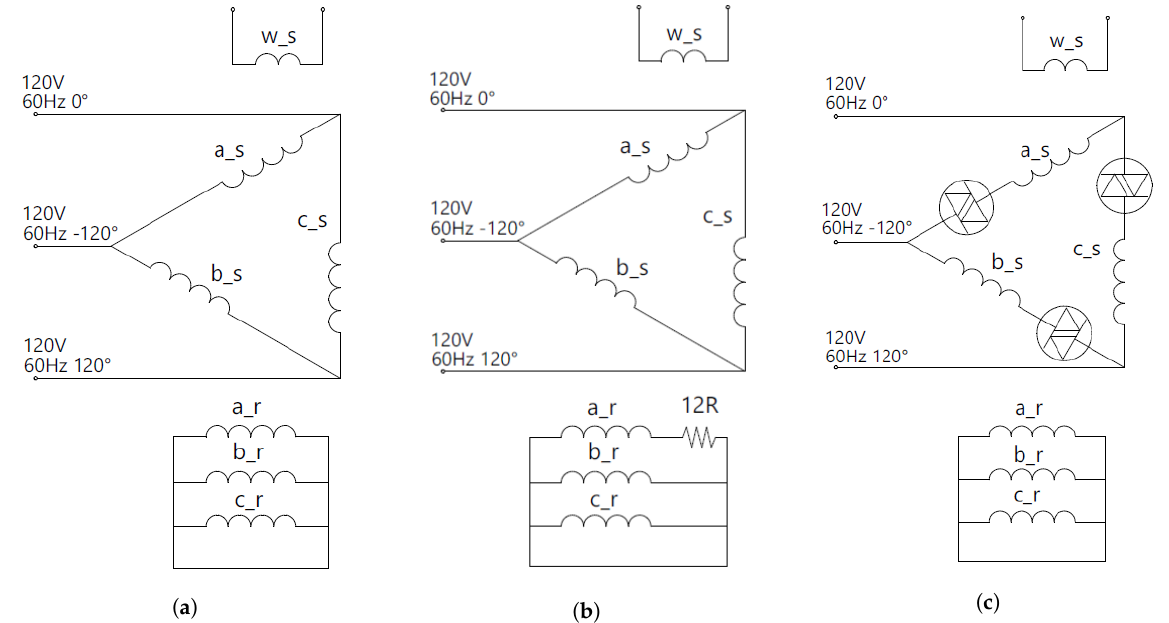
Figure 6. WRIM setups used for validation. ( a ) Balanced; ( b ) With rotor unbalance; ( c ) With TRIACs.